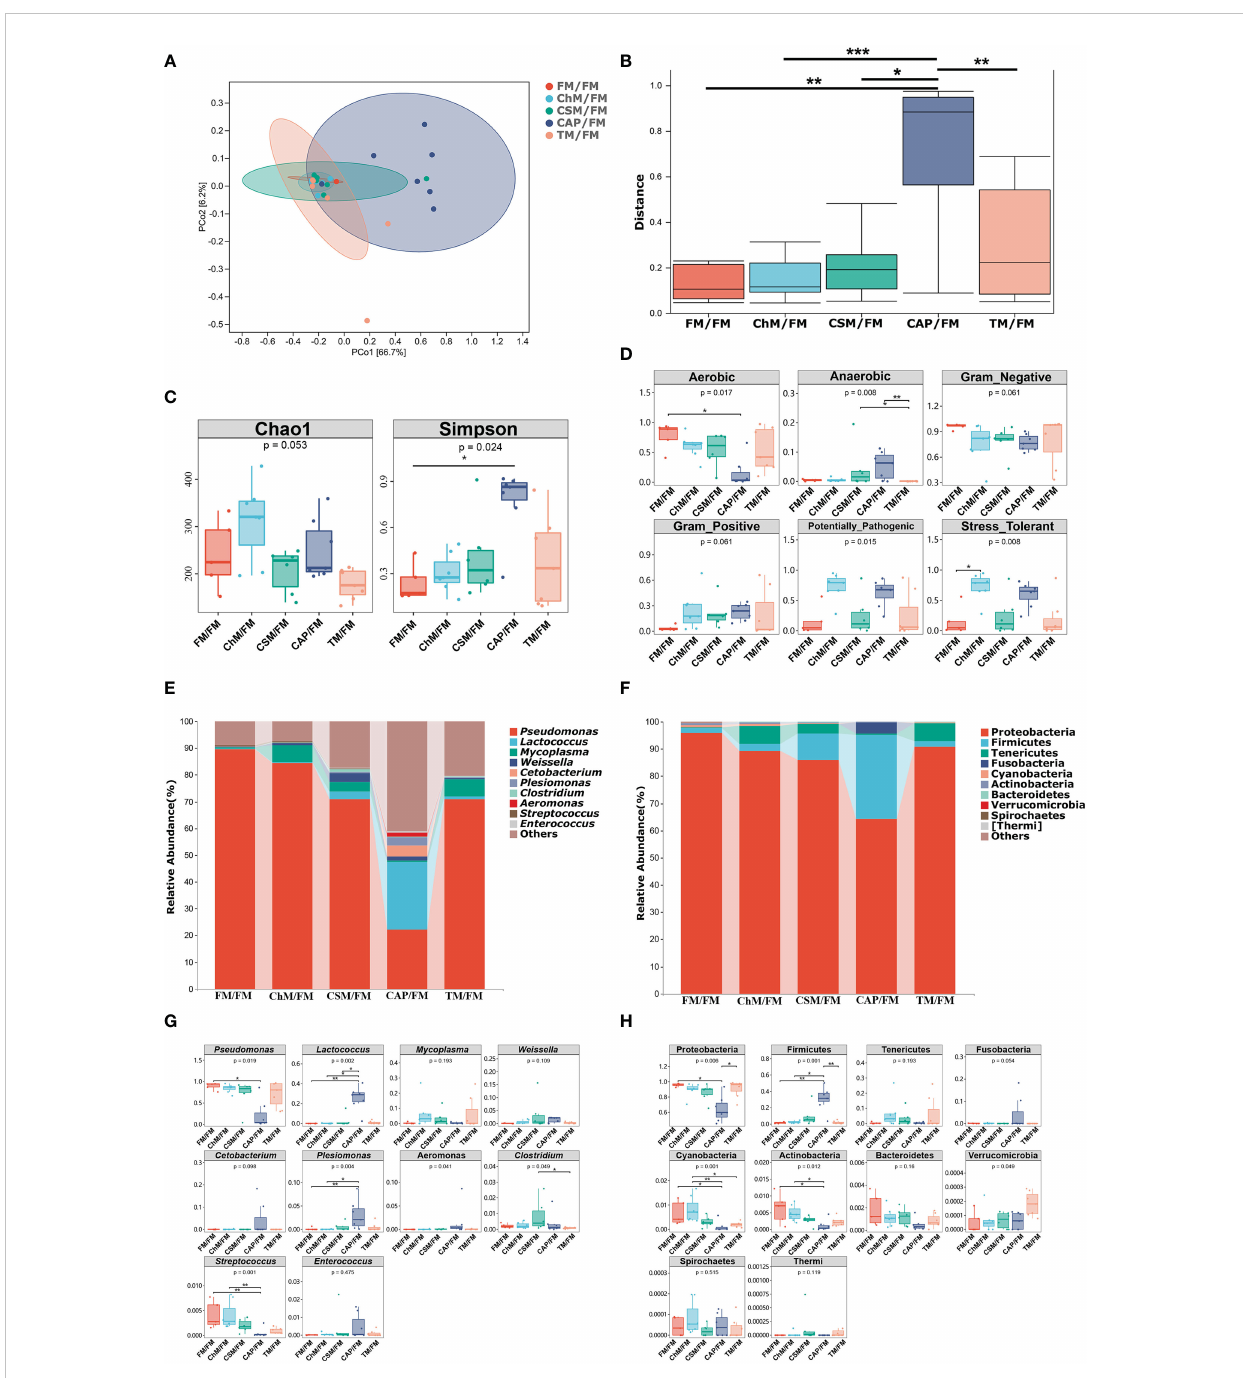
FIGURE 6 The intestinal microbiome of juvenile largemouth bass intestinal contents under an alternate feeding strategy were shown as follows: b -diversity (A) , abundance comparison of b -diversity (B) , a -diversity (C) , bugbase analysis (D) , top 10 microbiota at genus level (E) , Top 10 microbiota at phylum level (F) , abundance comparison of top ten microbiota at genus level (G) , and abundance comparison of top 10 microbiota at phylum level (H) .The statistical differences were presented as * P<0.05 ,** P<0.01 , and *** P<0.001